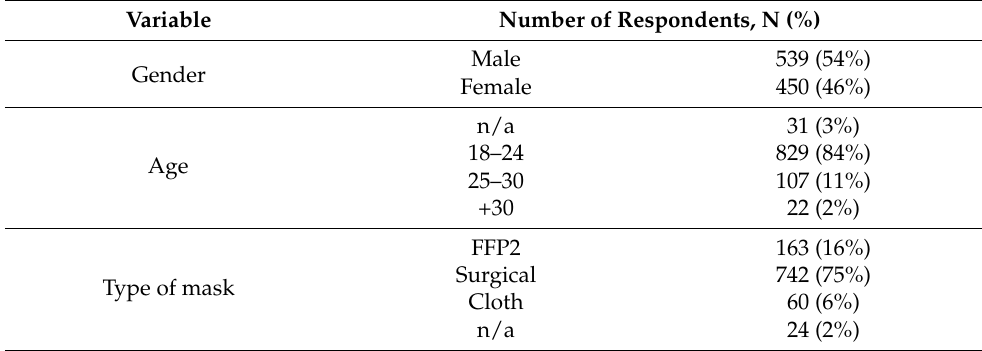
Table 5. Characteristics of the sensors used in the field measurement campaign.